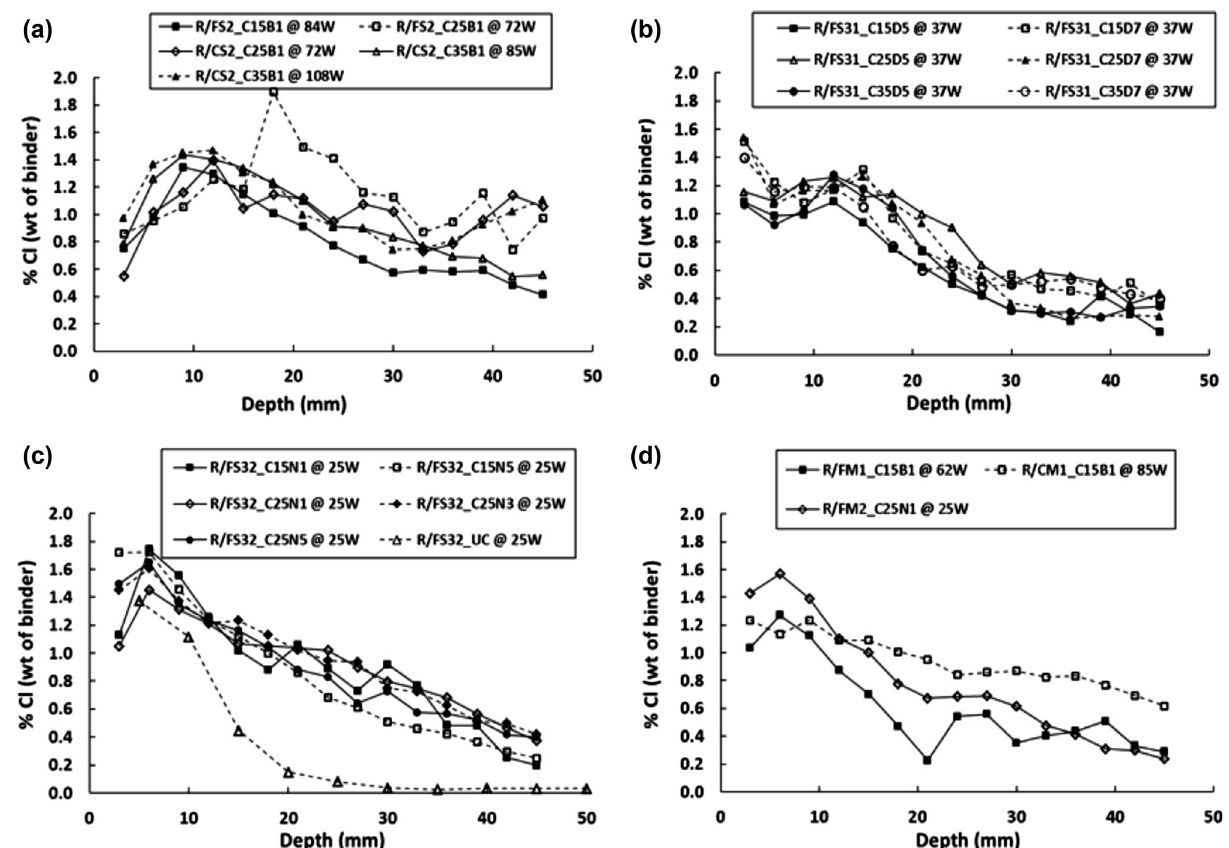
Fig. 12 XRF total chloride profile obtained in different R/SHCC and R/mortar specimens up to a depth of 45 mm, at different ages in weeks (W).